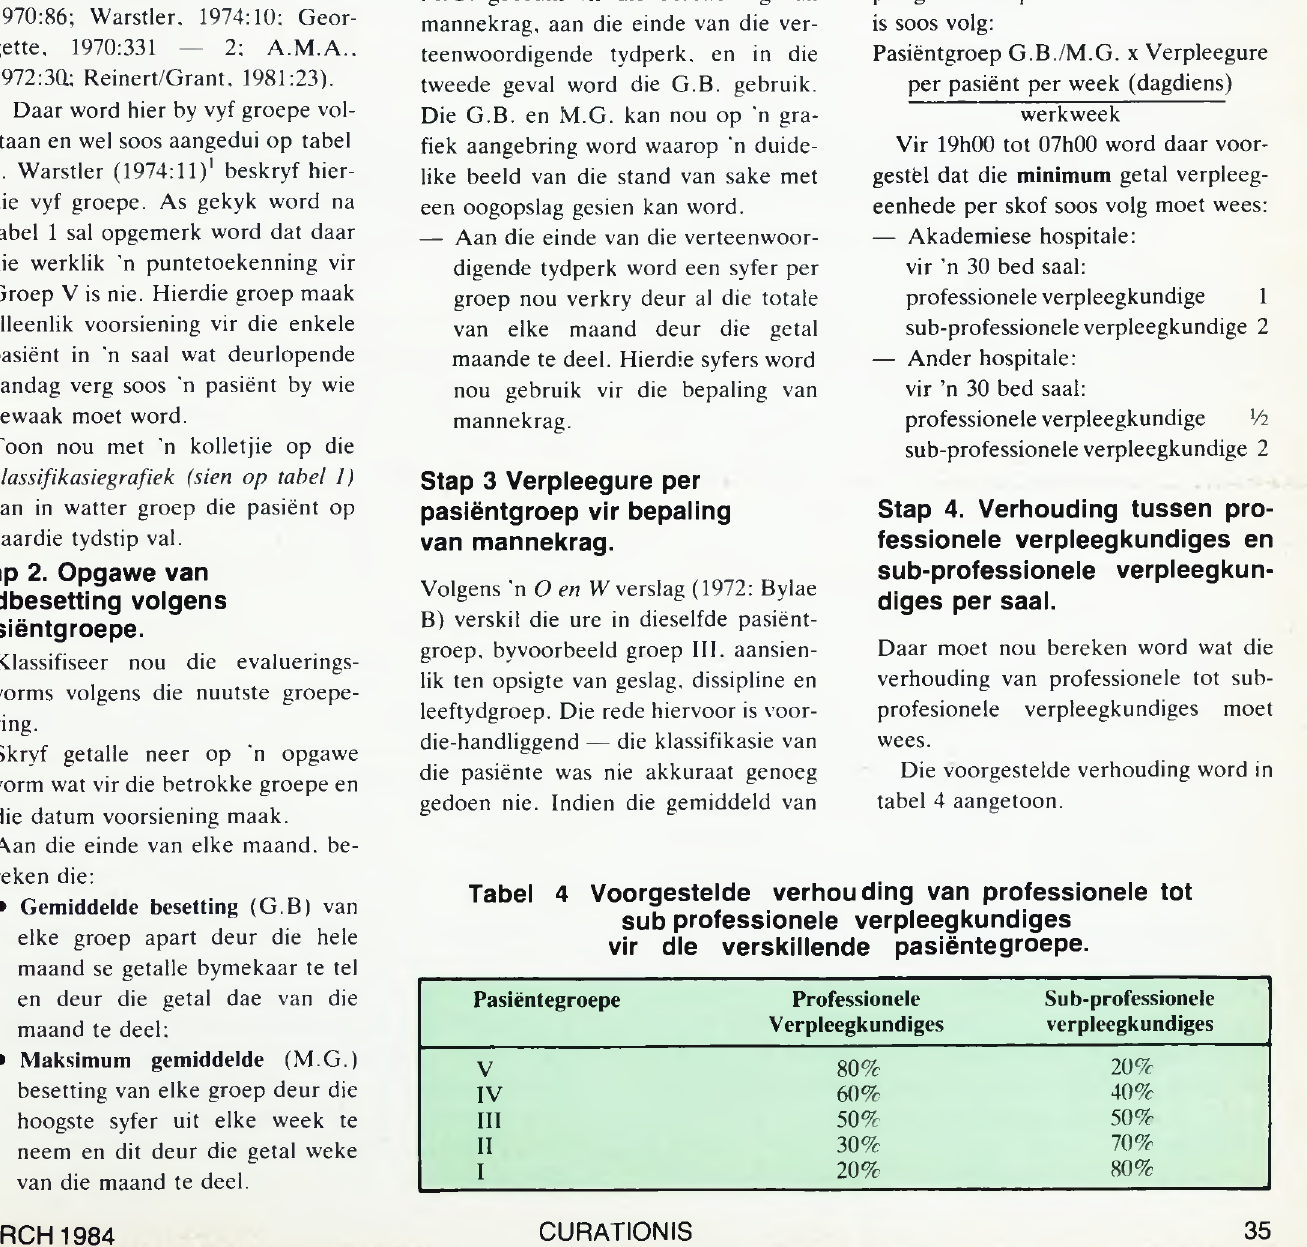
Tabel 4 Voorgestelde verhouding van professionele tot sub professionele